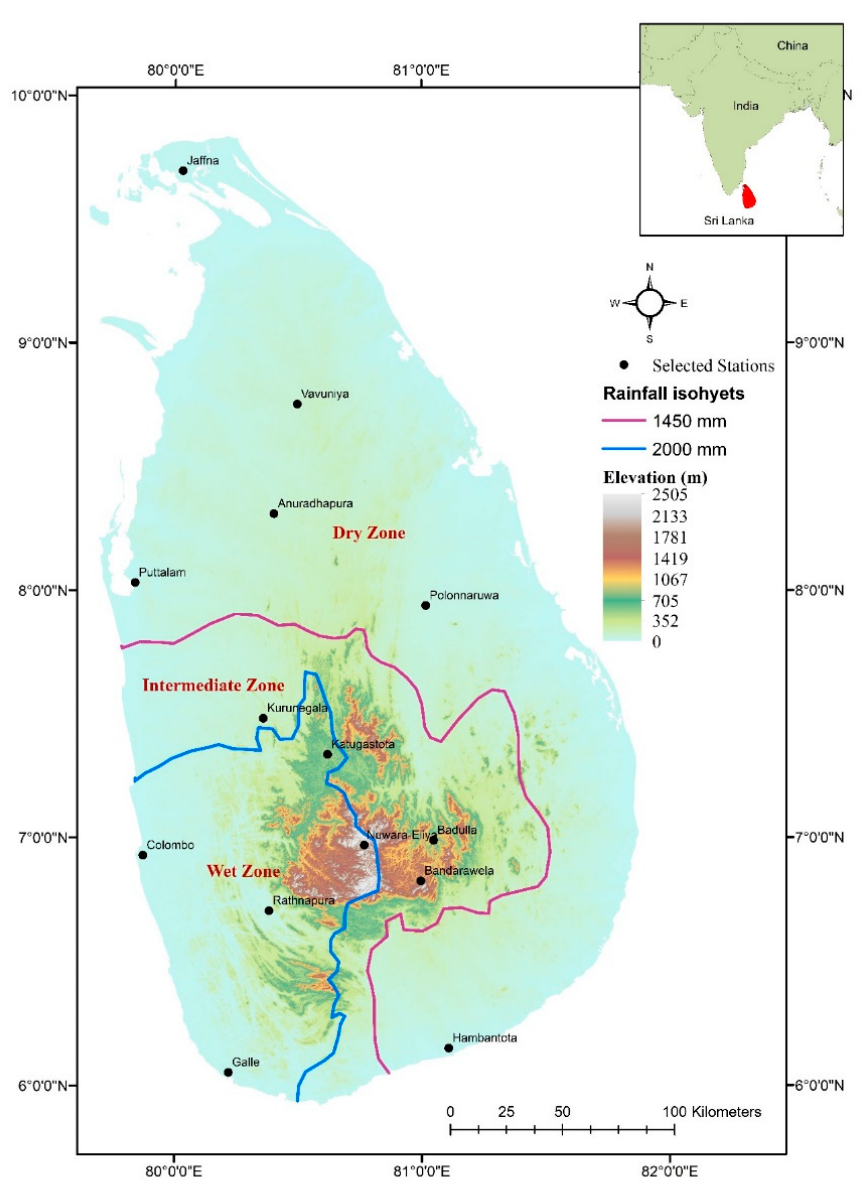
Figure 1. Map of Sri Lanka indicating three major climatic zones, topographic zonation and the selected weather stations. Rainfall isohyets delineating climatic zones were drawn based on Climate Change Secretariat Sri Lanka [28].